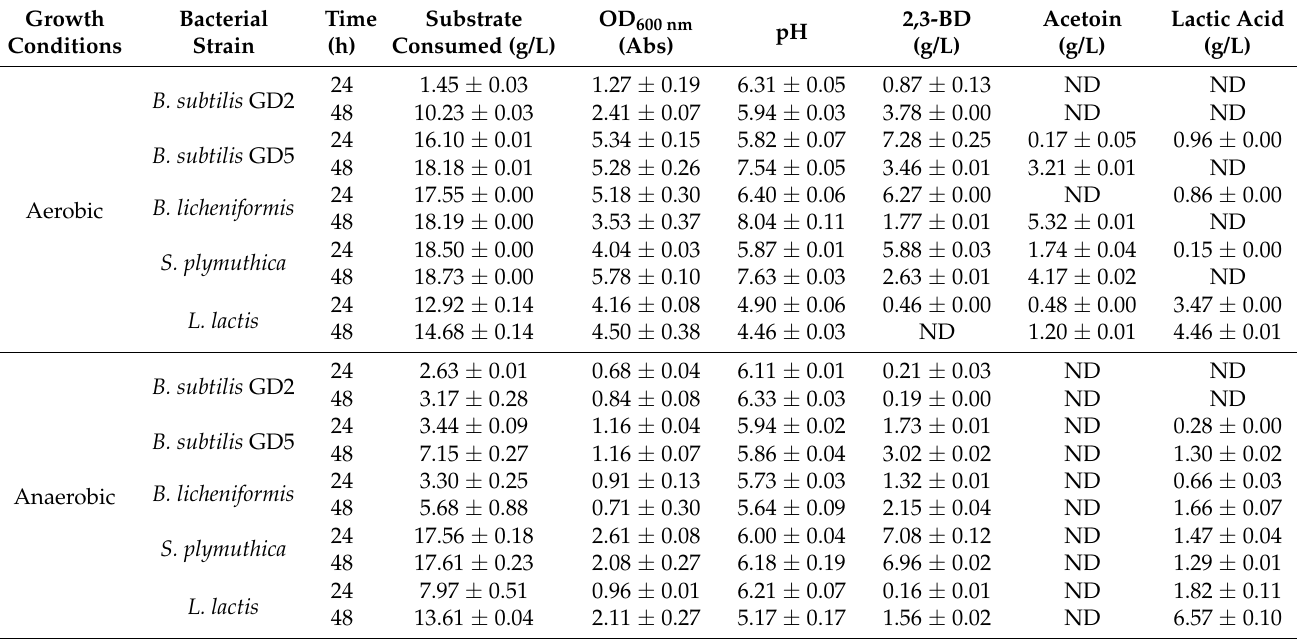
Table 1. Cell growth, pH and 2,3-BD production in sucrose-based media by various bacterial strains under aerobic (shake-flask) and anaerobic (Duran bottles)